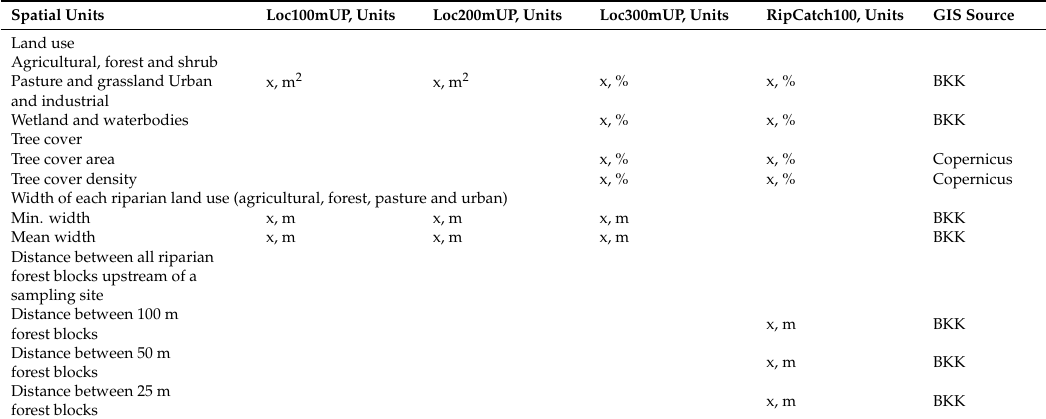
Table 1. The spatial units and the quantified riparian attributes considered in this study. Quantified attributes are indicated with